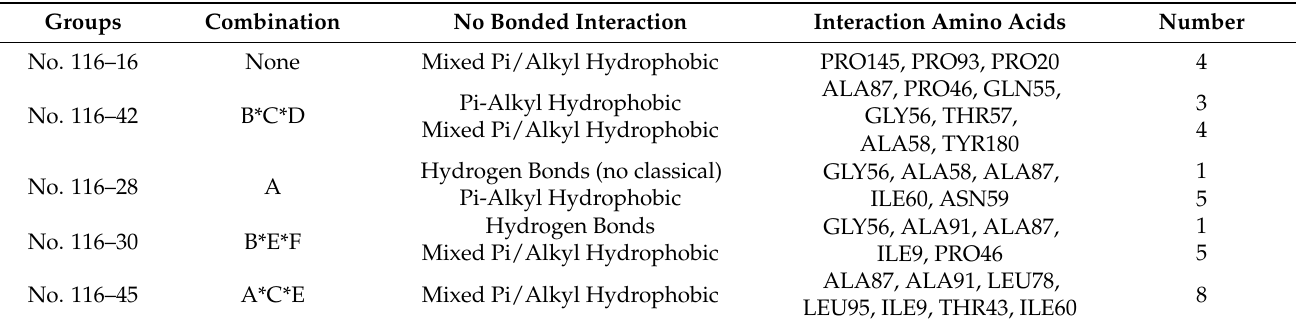
Figure 5. Amino acid residue diagram of polystyrene 5 polymer interacting with degrading enzyme (7CC4) under the condition of external additive with obvious positive effect. (After molecular dynamics simulation, the complex of ligand and degrading enzyme (7CC4) was extracted, and the interaction between ligand and degrading enzyme was analyzed. The yellow circle represented the main amino acid residues in the interaction between degrading enzyme (7CC4) and polystyrene pentamer). Table 7. Significantly positive non-bond interactions between polystyrene 5 polymers and 7CC4 in the presence of exogenous additives.